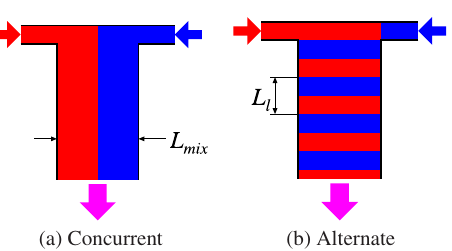
Fig. 1 Expected flow pattern generated by alternate pumping.